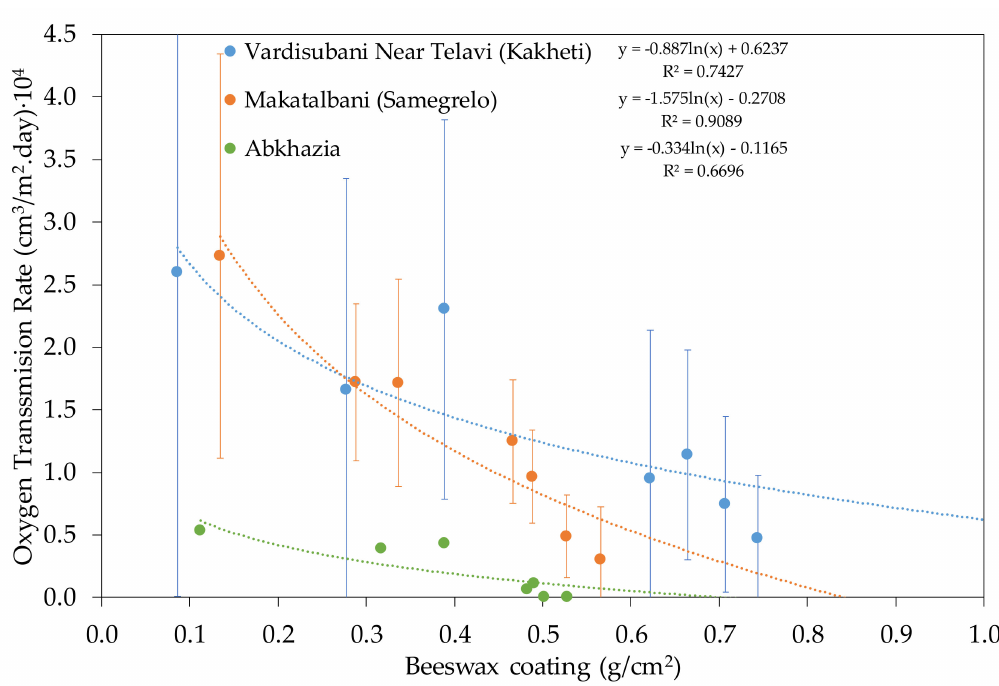
Figure 11. Evolution of OTR in the pieces of Qvevri from different regions as a function of beeswax coating.